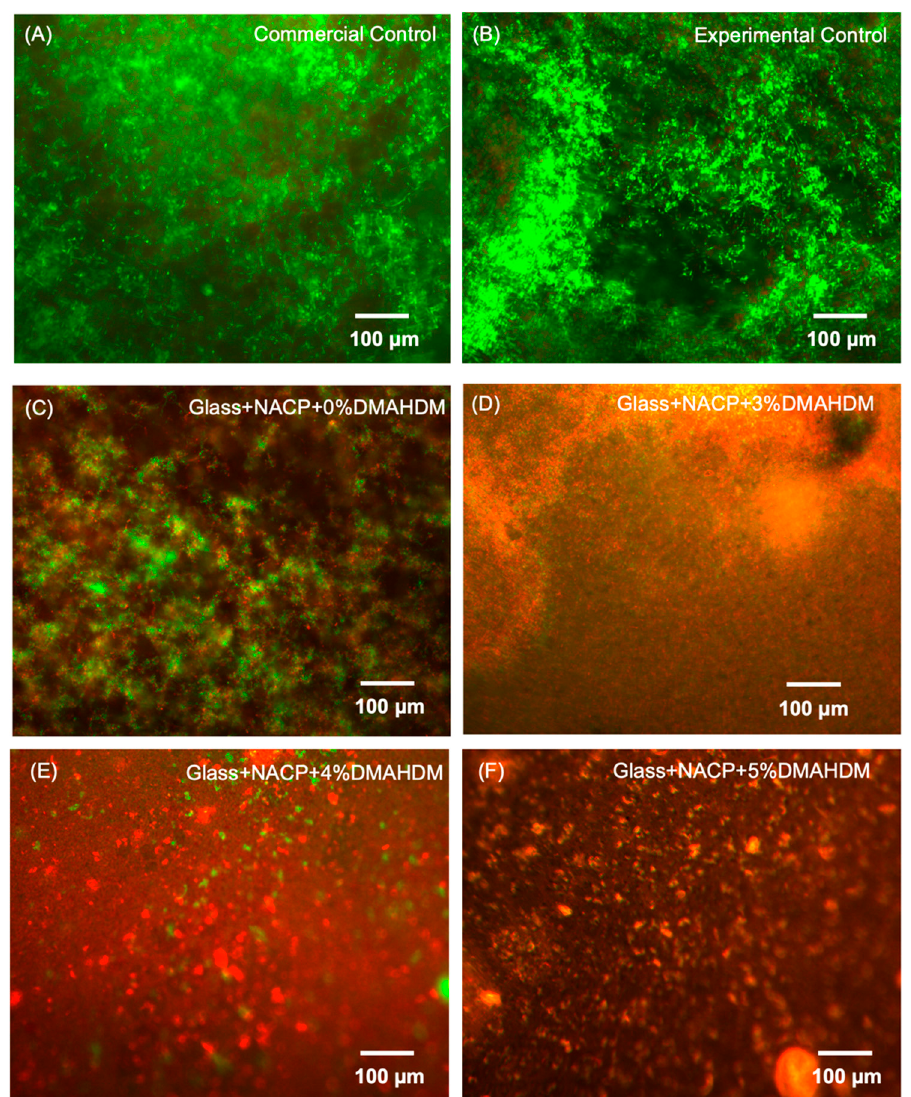
Figure 8. Demonstrative live / dead staining images of 2-day S. mutans biofilms: live bacteria were stained green, and compromised bacteria were stained red. Mixed live and dead bacteria produced yellow / orange colors. ( A – C ) Commercial, experimental control, and NACP + 0%DMAHDM cements were mostly covered by live bacteria. ( D – F ) In contrast, NACP + DMAHDM cement had significant amounts of dead bacteria.